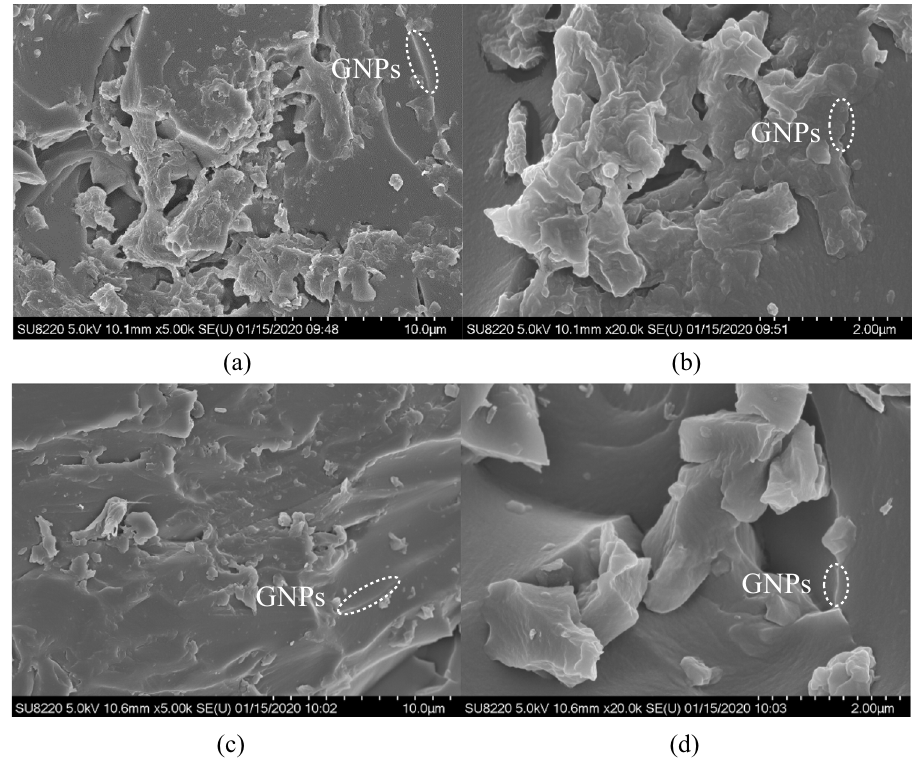
Figure 14: Microstructure imaging of GNP - reinforced epoxy at 0.025 wt% GNPs at ( a ) 5,000 × and ( b ) 20,000 × ; 0.4 wt% GNPs at ( c ) 5,000 × and ( d ) 20,000 ×